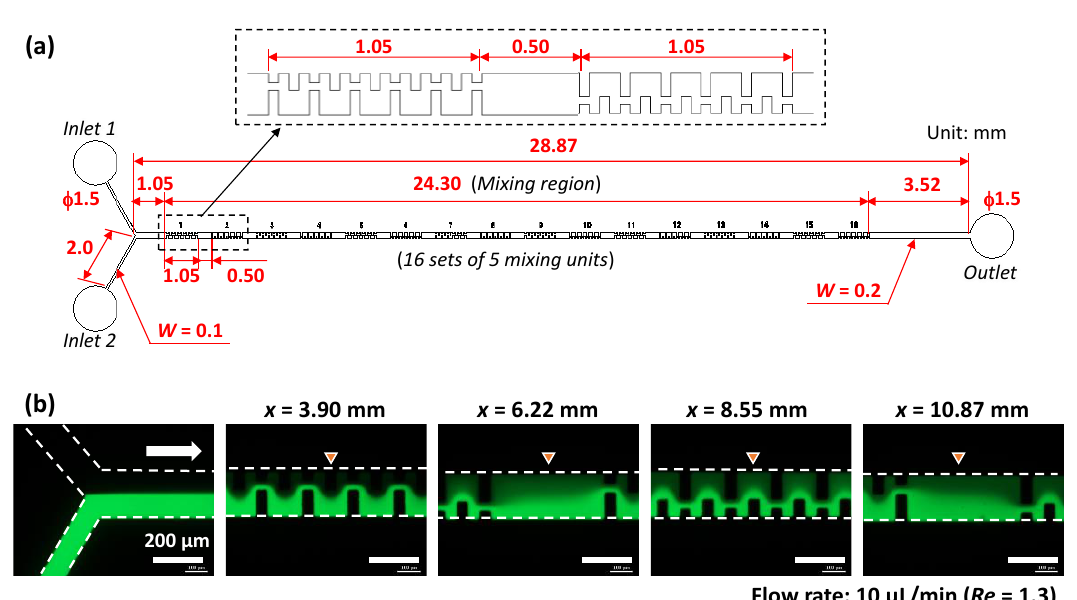
Figure 4. Experimental investigation of the influence of the number of mixing units for a single set on the mixing efficiency. ( a ) Detailed design of the asymmetric mixer with sixteen sets of five mixing units employed in the experiments. ( b ) Fluorescence microscopy images of the mixing process, in which pure water and fluorescein-dyed water (0.1 mol/m 3 ) were introduced at the same flow rate of 5 µL/min (a total flow rate of 10 µL/min and Re = 1.3).